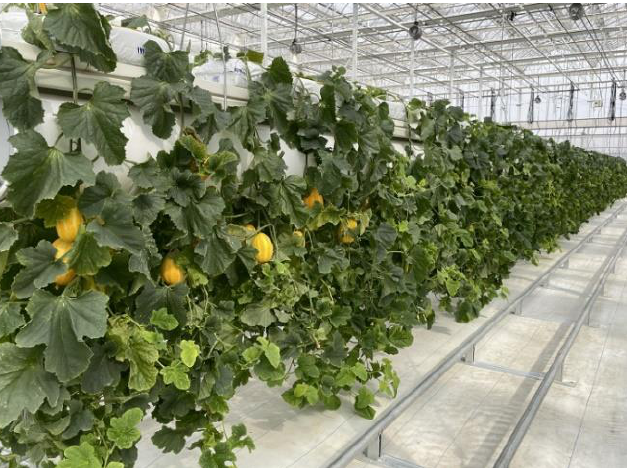
Figure 1. Image of hydroponic greenhouse in the Republic of Korea (National Institute of Agricul- tural Sciences).